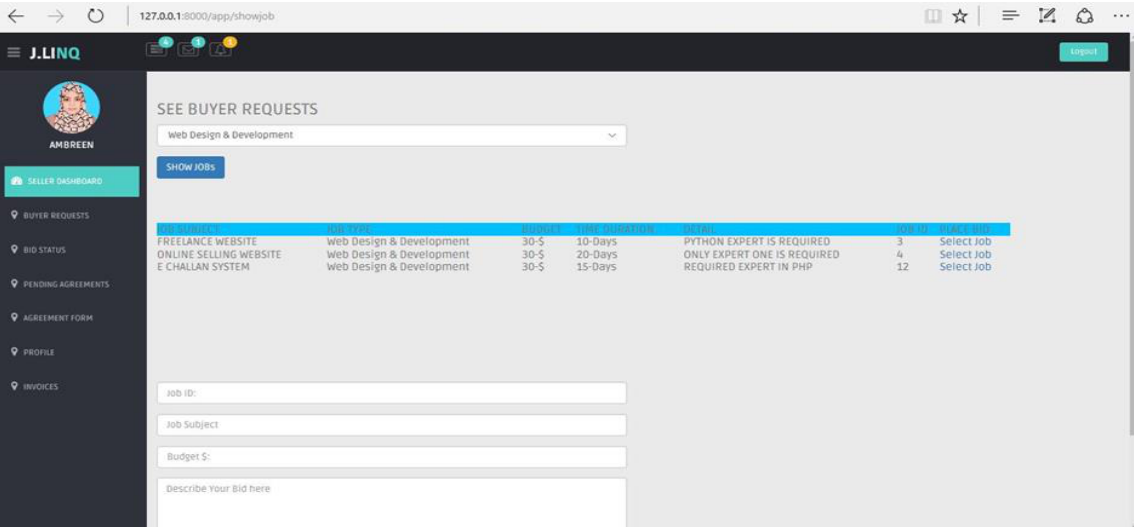
Figure 15. Job searching interface in the seller dashboard.